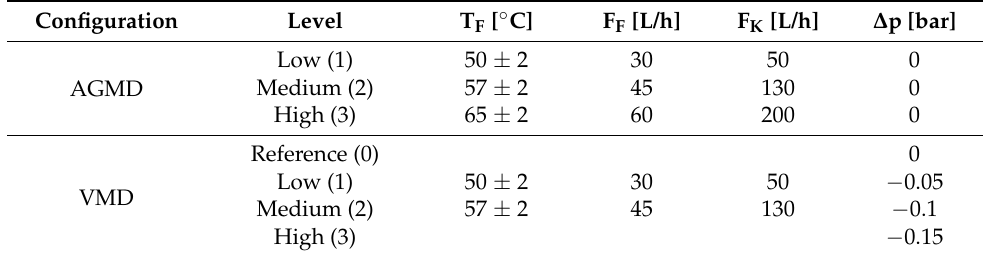
Table 4. Conditions of factor variation